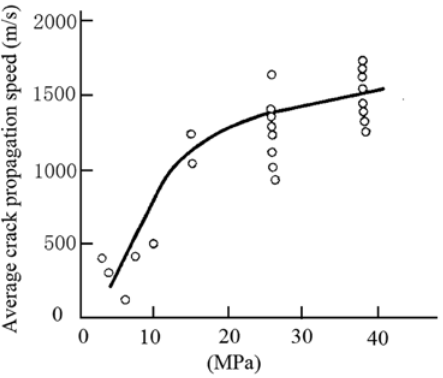
Figure 2: The dependence of crack propagation speed on applied